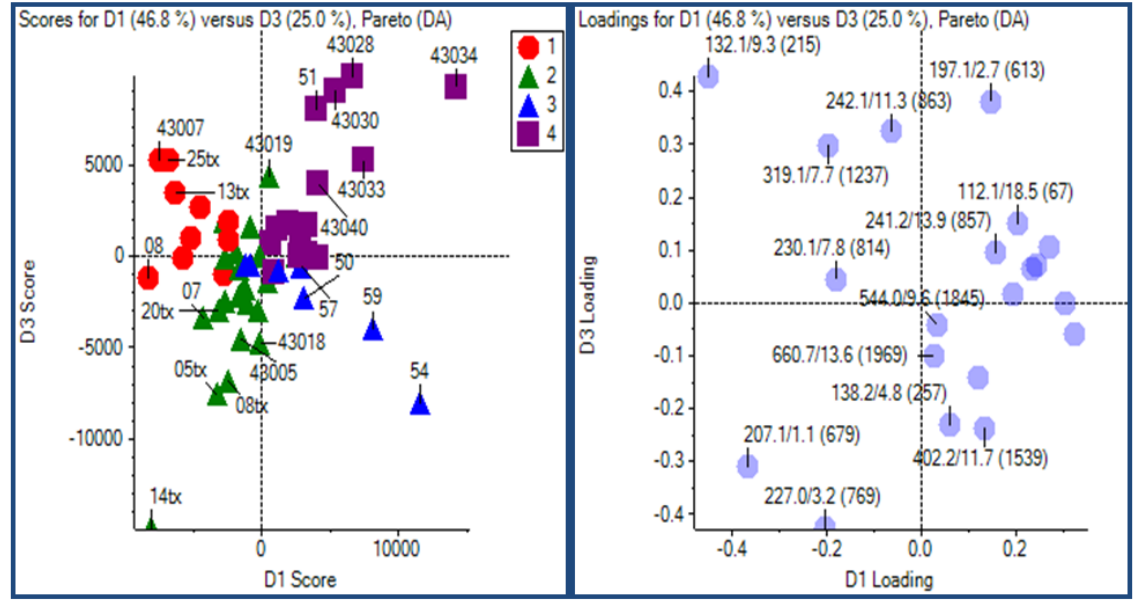
Figure 8. PCA-DA plot of the ccRCC HILIC-LC–ESI–MS after GA feature selection. Groups were color-coded as: 1-red: female ccRCC, 2-green: male ccRCC, 3- blue: female control, 4-purple: male control. 55 samples, 22 predictors.